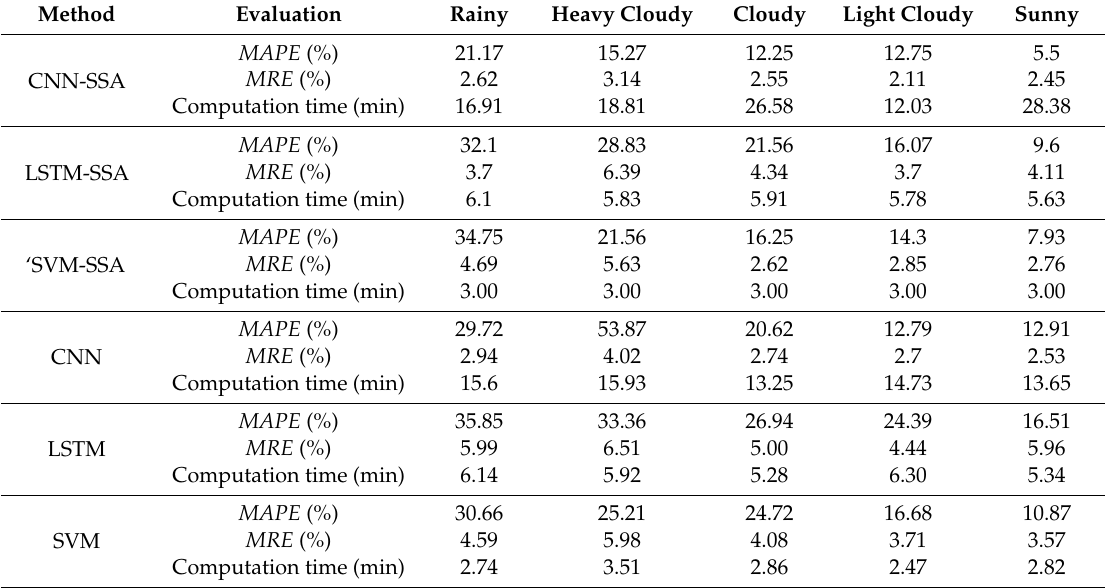
Table 5. Forecasting results comparison with benchmark